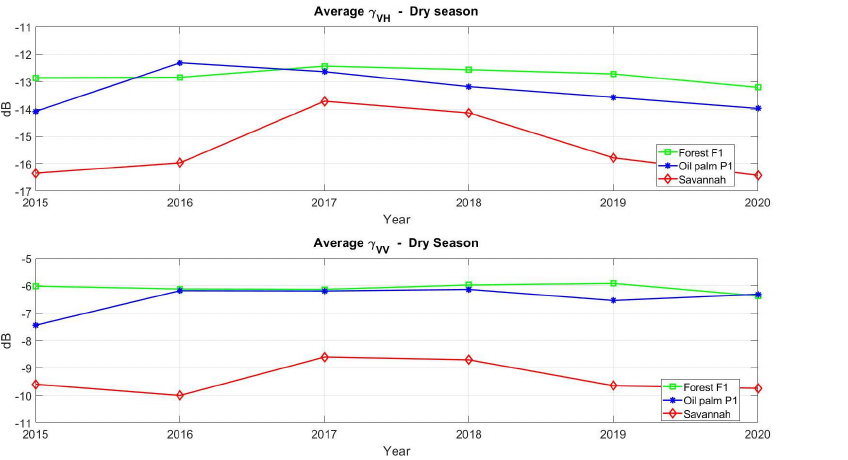
Figure 10. Time series for F1, P1 and S polygons for the dry season of: ( top ) VH; and ( bottom ) VV.